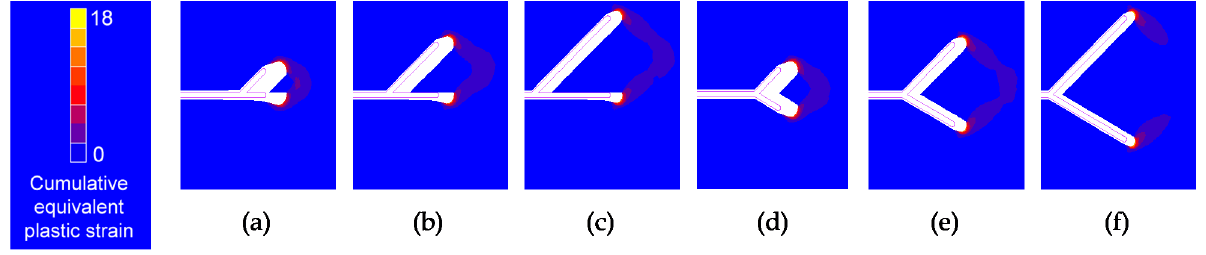
Figure 11. Initial and final crack tip profile and cumulative equivalent plastic strain in the vicinity of bifurcated crack tip with different initial branch angle and Δ K = 31.25 MPam 1/2 : ( a ) α 2 = 0°, l ´ = 25 µm; ( b ) α 2 = 0°, l ´ = 50 µm; ( c ) α 2 = 0°, l ´ = 75 µm; ( d ) α 2 = 30°, l ´ = 25 µm; ( e ) α 2 = 30°, l ´ = 50 µm; ( f ) α 2 = 30°, l ´ = 75 µm.